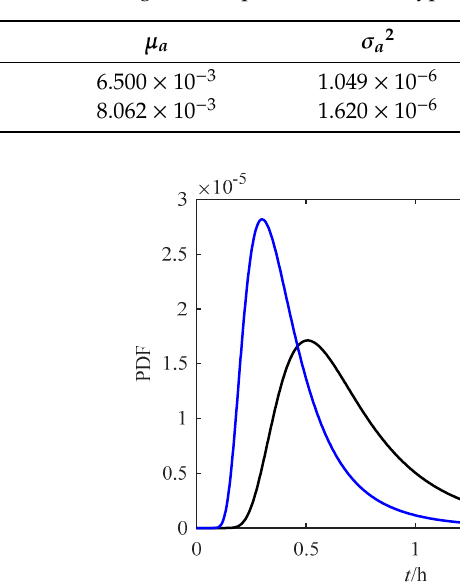
Figure 8. Comparison of PDF of storage lifetime at 60 °C for O-type rubber seal rings. Figure 9. Comparison of PDF of storage lifetime at 70 °C for O-type rubber seal rings.